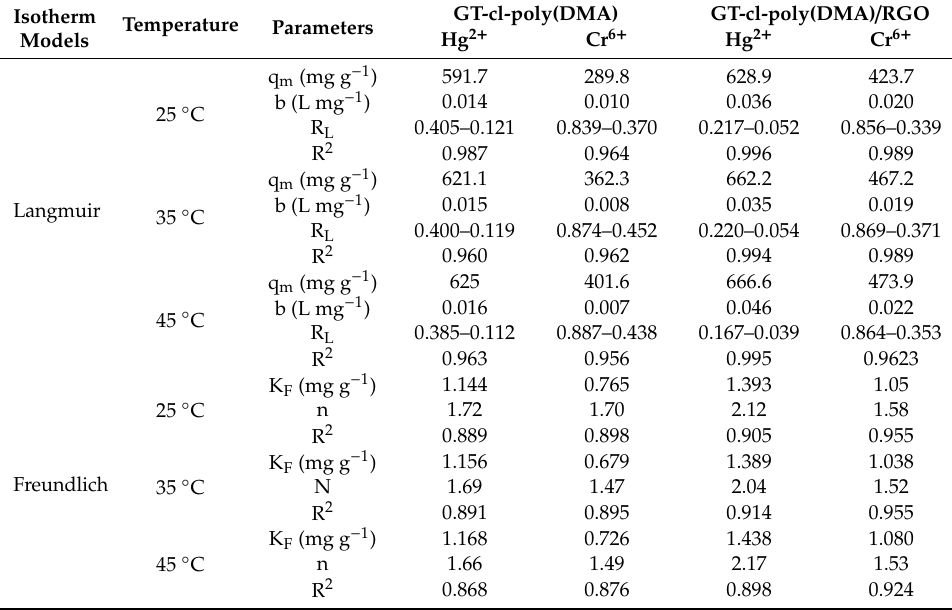
Table 5. Isotherm model parameters for Hg 2 + and Cr 6 + adsorption by GT-cl-poly(DMA) hydrogel and GT-cl-poly(DMA) / RGO hydrogel